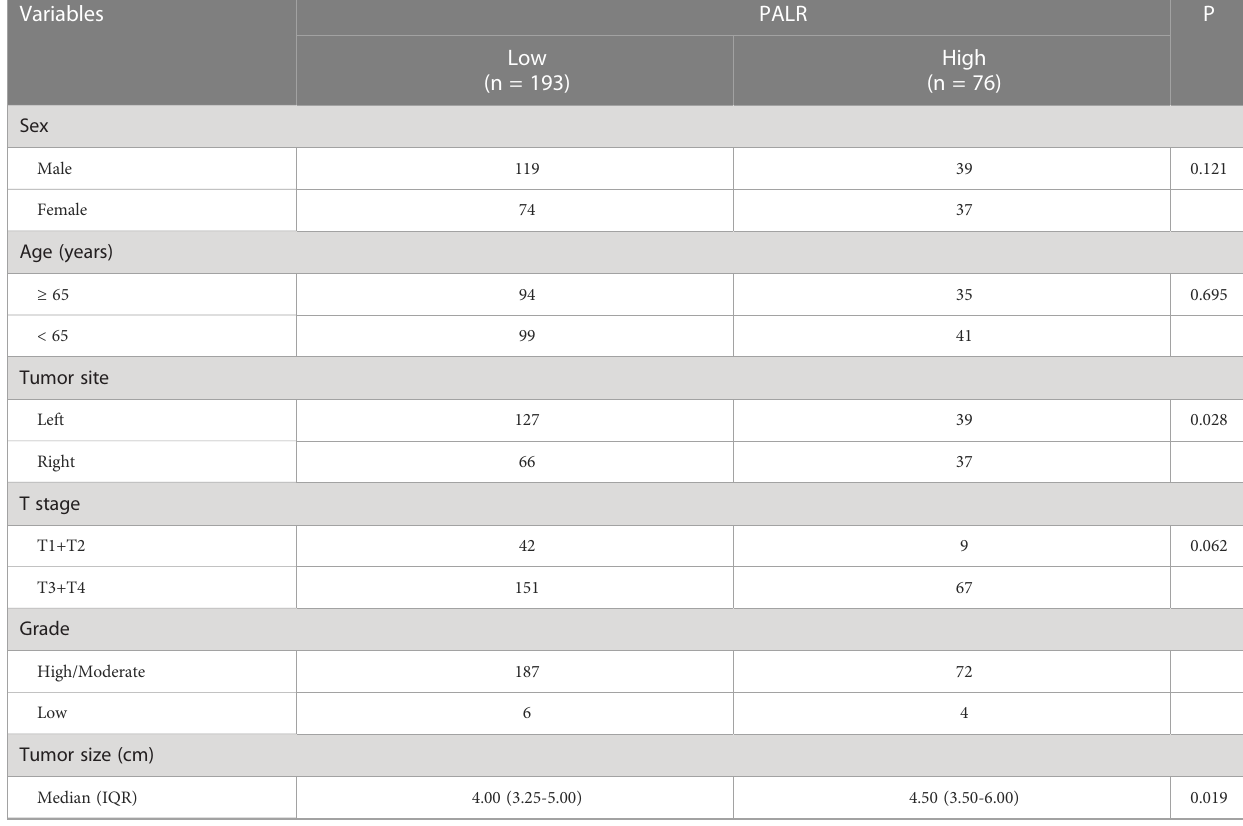
TABLE 3 The relationship between clinicopathological variables and PALR.